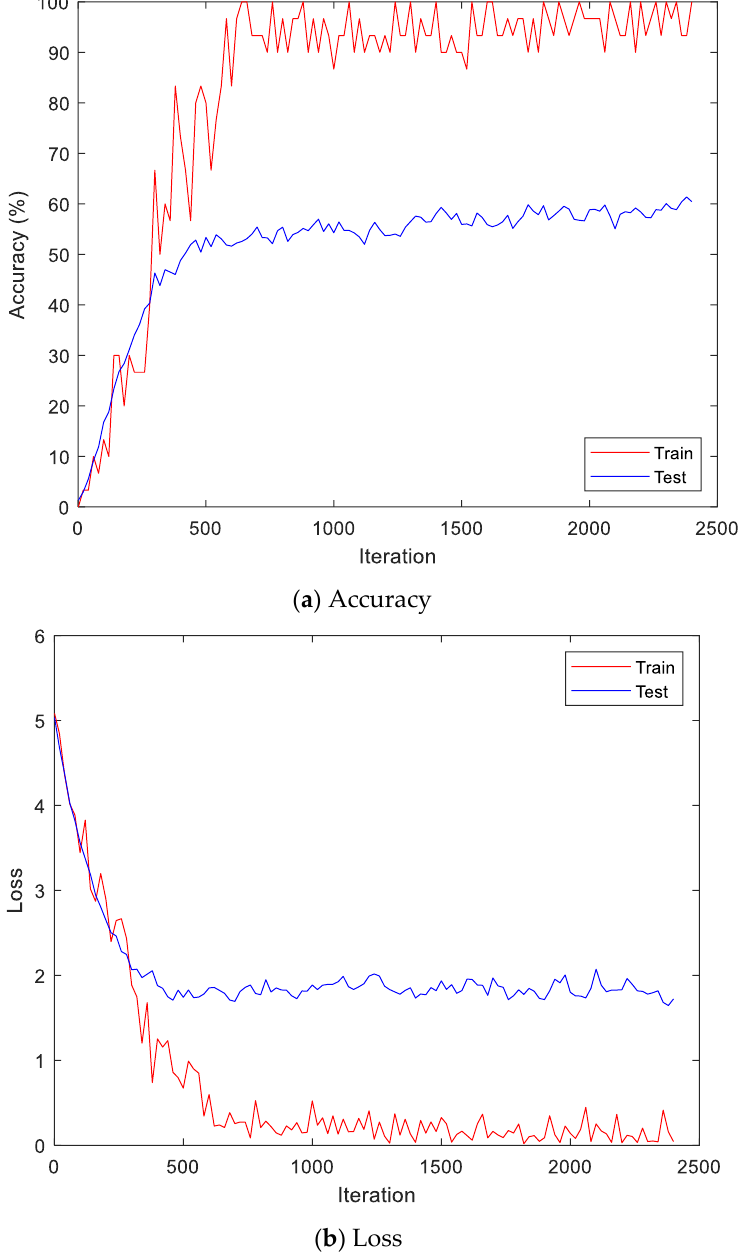
Figure 13. Training process by the scalogram and CNN-based individual identification model (CU-EMG-ECG dataset).